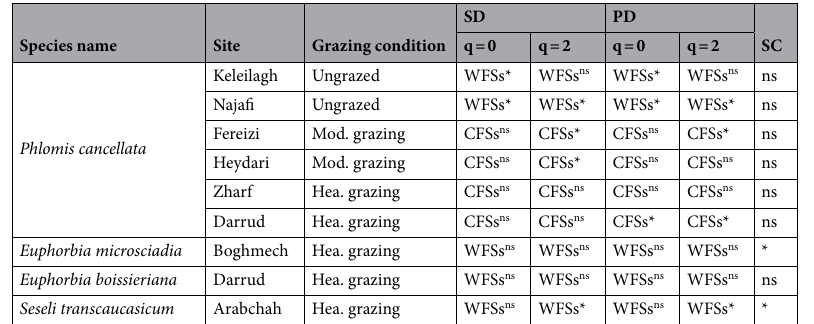
Table 2. Summary of the effects of four unpalatable species on neighboring communities. For SD and PD, a community with a higher value is reported in the table. Abbreviations: SD species diversity; PD phylogenetic diversity; SC species composition; CFSs contain focal species; WFSs without focal species; ns no significant difference. *Indicated a significant difference at a 5% significance